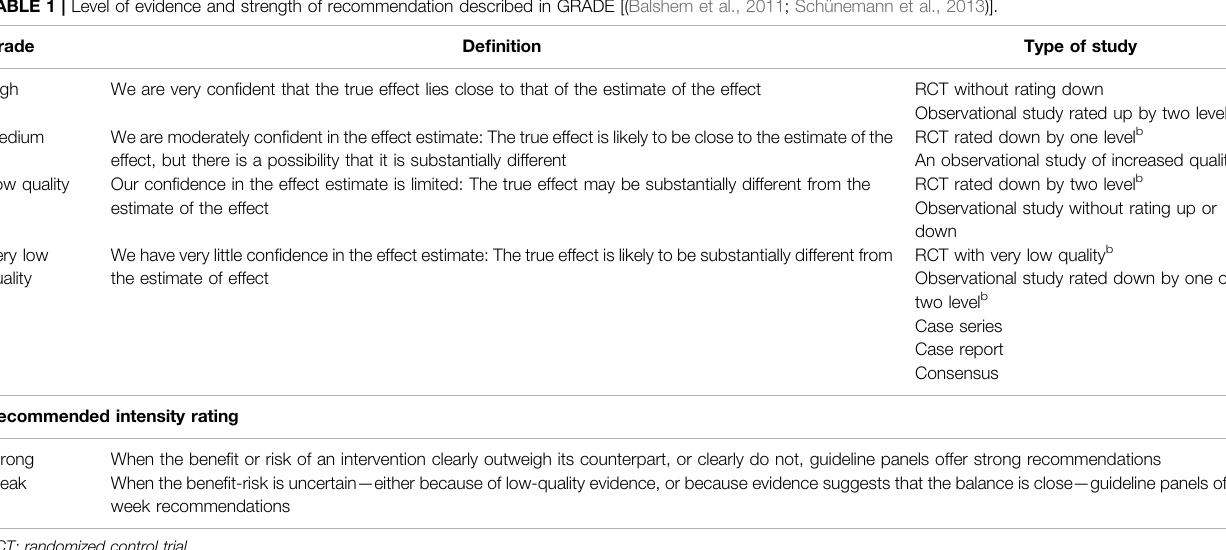
TABLE 1 | Level of evidence and strength of recommendation described in GRADE [(Balshem et al., 2011; Schünemann et al.,